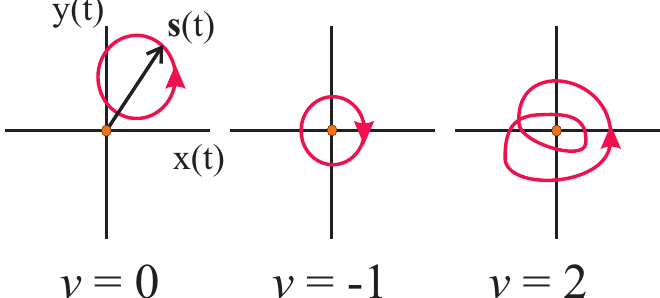
Figure 1. The winding number ν ∈ Z of a continuous curve about some point p counts the number of times the curve encircles p . Here, p ia taken to be the origin, and the curve parametrized as s ( t ) : R → R 2 in the plane can be given a polar coordinate description via functions { r ( t ) , φ ( t ) } , with parameter t (0 ≤ t ≤ 1). Specifically, s ( t ) = r ( t ) · ( cos φ ( t ) ,sin φ ( t )) , with φ ( 1 ) = φ ( 0 ) + 2 πν